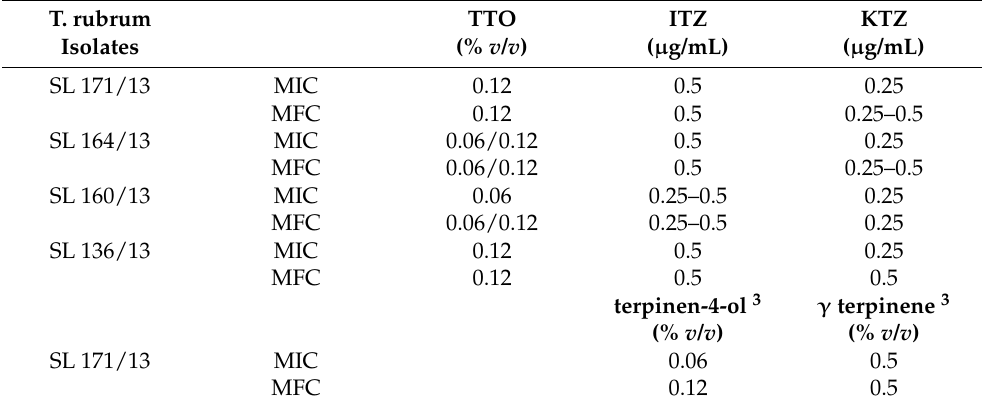
Table 2. MIC 1 and MFC 2 of Tea Tree Oil (TTO) and azoles (used as reference drugs) against Trichophyton rubrum strains.